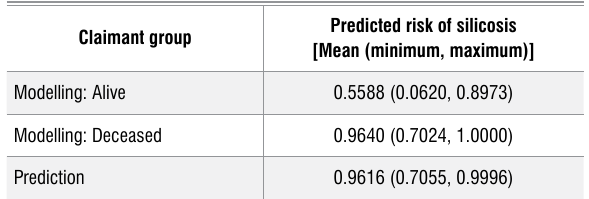
Predicted risk of silicosis Claimant group